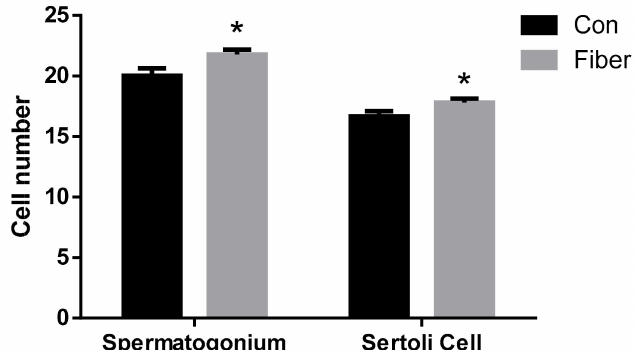
Figure 2. Testis tissue cross-sections of piglets, stained in hematoxylin-eosin. ( A ) testis of piglets in control group, 400 × . ( B ) Testis of piglets in fiber group, 400 × . (a) Stood for Sertoli cell and (b) stood for spermatogonia.